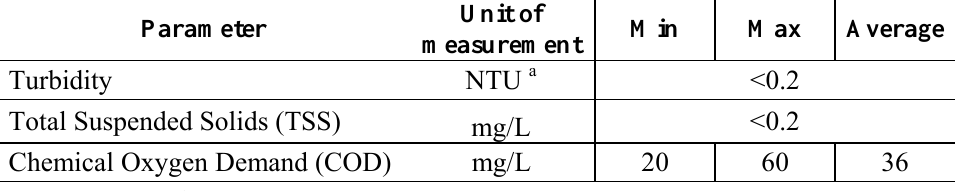
Table 3. UF permeate wastewater characteristics during the SOC and COC